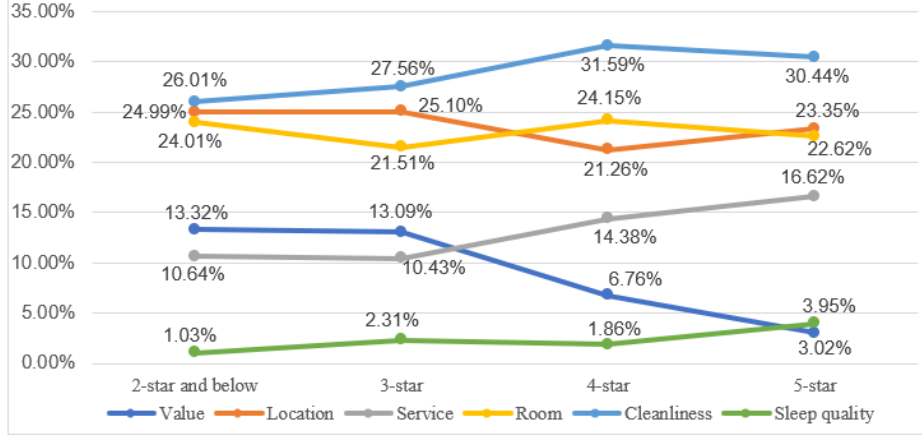
Figure 6. The percentage of positive sentiment values concerning six attributes.